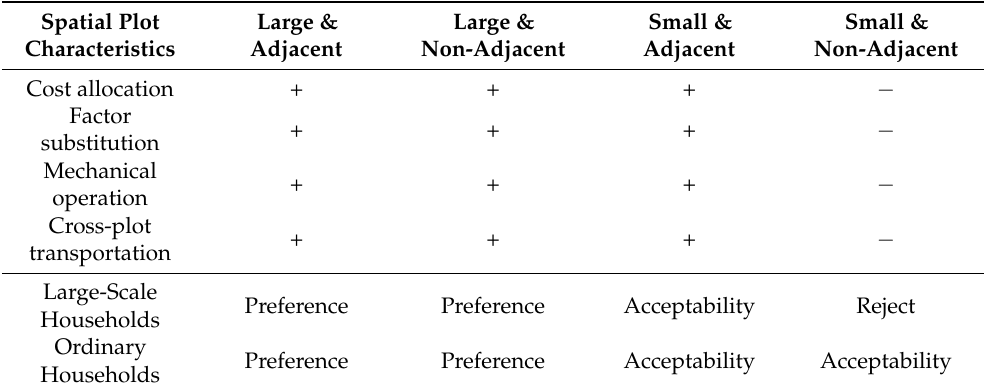
Small & Small & Adjacent Non-Adjacent